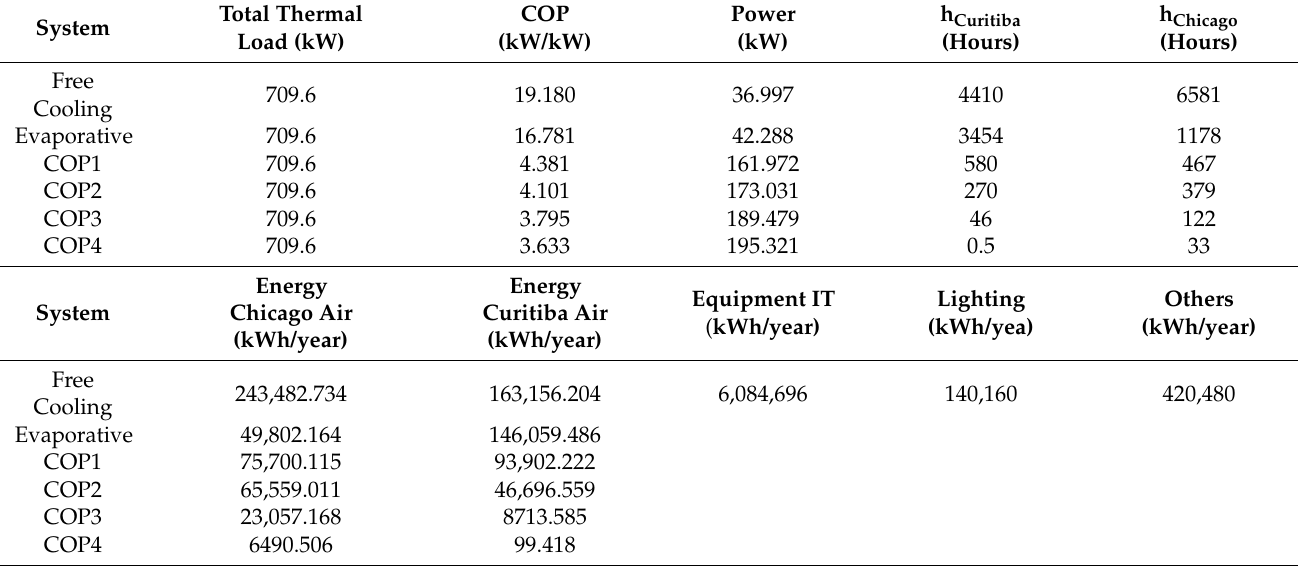
Table 7. Results using Energy Usage Effectiveness Design (EUED) indicator rules (adapted from [21]).